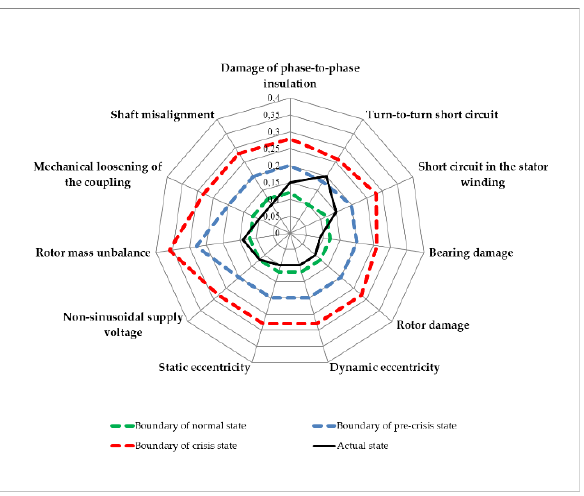
Figure 7. Graph for probabilistic pre-crisis state of the unit.